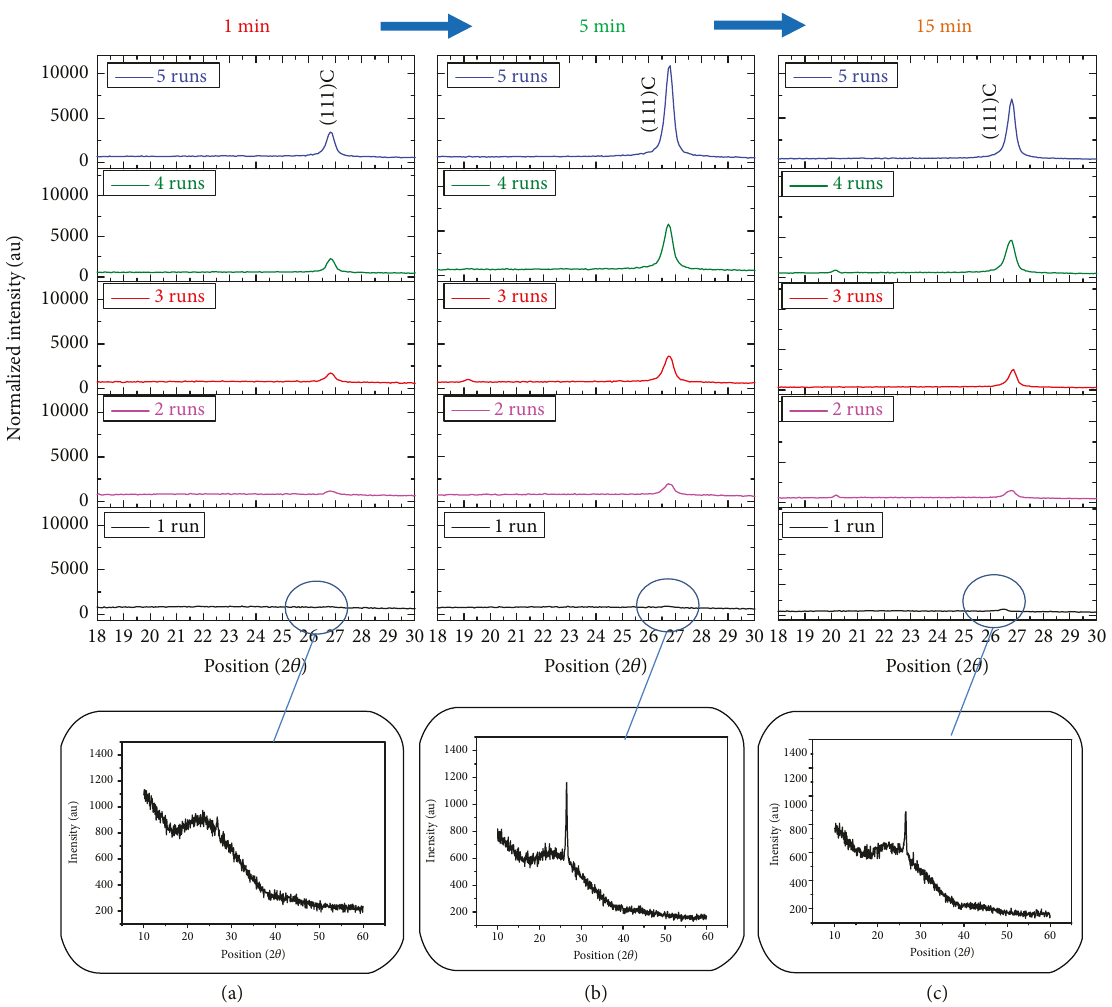
Figure 1: X-ray di ff ractograms of CdS thin fi lms prepared in di ff erent runs and deposition times: (a) 1min, (b) 5 min, and (c) 15